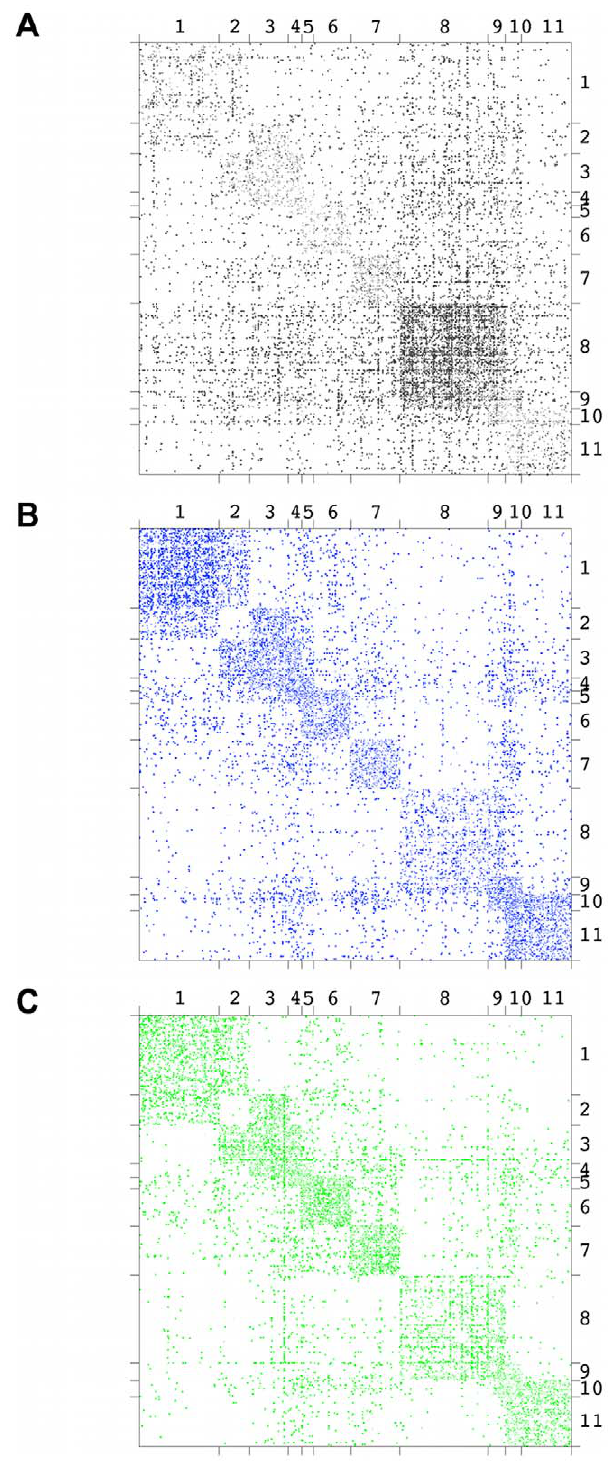
Figure 7. Comparison of block assignment. The same assignment of nodes into 11 classes as used in figure 5 but for 3 different types of interactions, separately. A Interactions reported only for yeast-2-hybrid experiments (grey). B Interactions reported only in in-vitro experiments (blue). C Interactions reported only in in-vivo experiments (green). While in-vitro and in-vivo data is highly correlated, the interactions found in Y2H experiments are enriched in class 8.